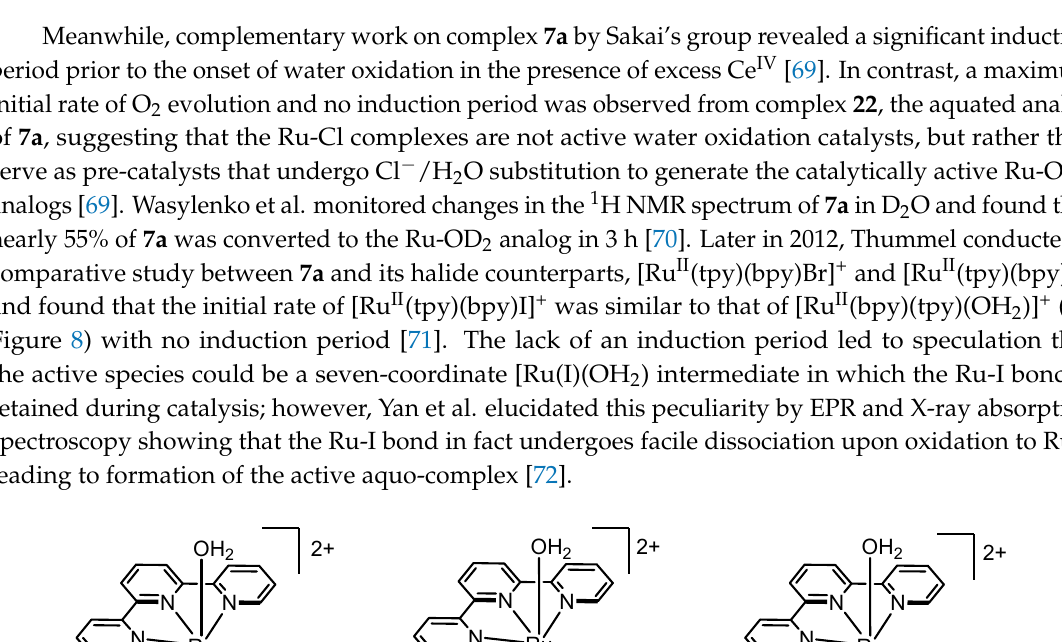
Figure 8. Aquated Ru(tpy)(NN) complexes that have played an important role in mechanistic elucidation of water oxidation at Ru.